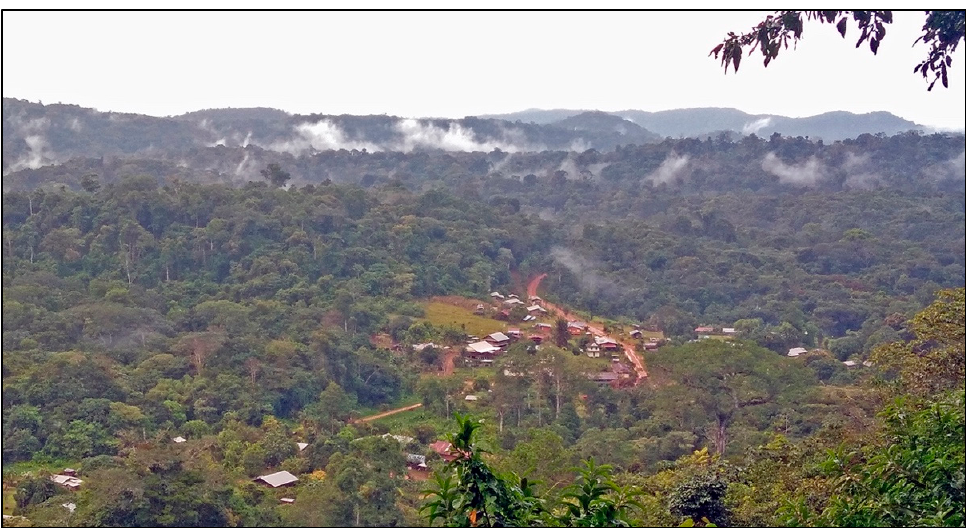
Figure 4. The village of Saül (Source: Luc